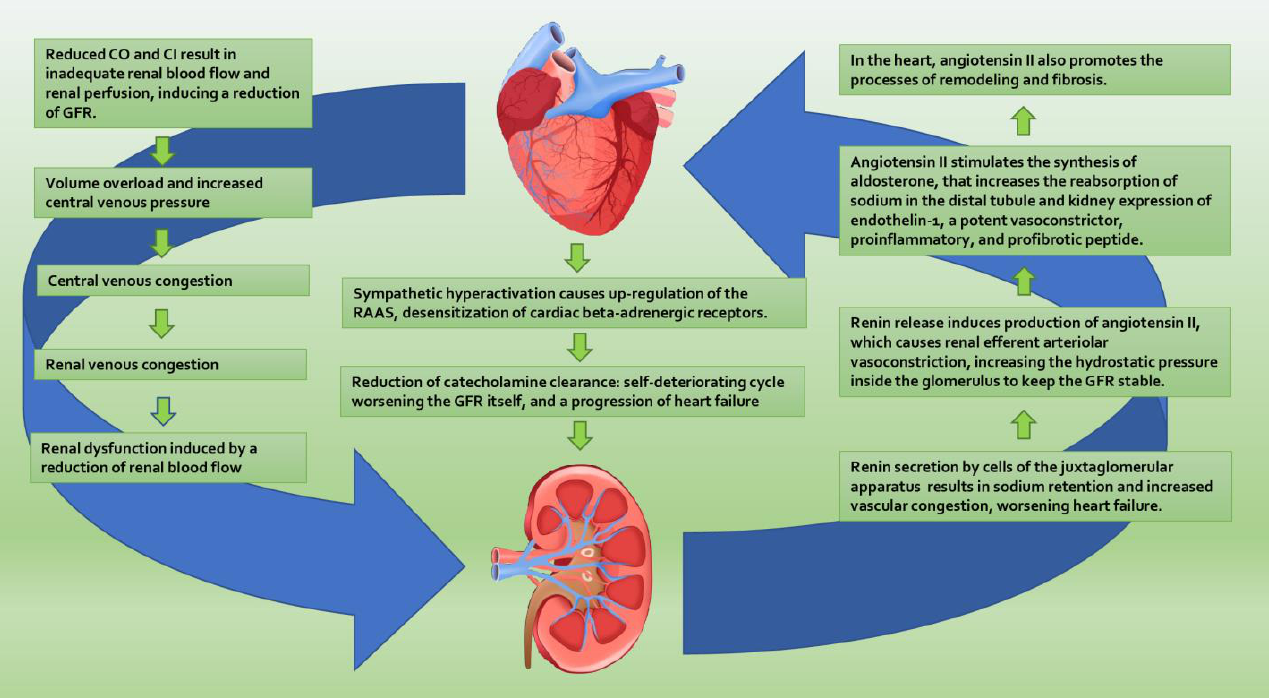
Figure 2. Bidirectional mechanisms in cardiorenal axis pathophysiology. CRS presents a common pathogenesis characterized by hemodynamic, neurohormonal, inflammatory mechanisms also involving the atherosclerotic degeneration. RAAS system plays a major role in CRS pathophysiology, tipping the scale in the delicate balance between heart and kidney. Abbreviations: CI: cardiac index, CO: cardiac output, GFR: glomerular filtration rate, RAAS: renin–angiotensin–aldosterone system.